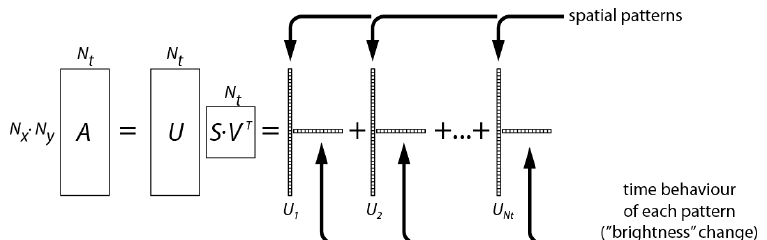
Figure 4. Explanation of Singular Value Decomposition (SVD) [24].